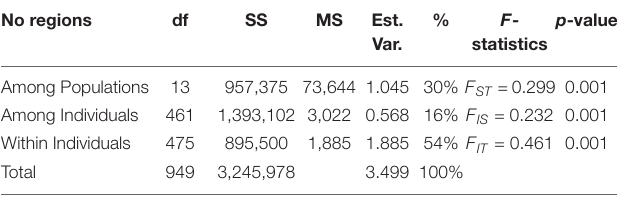
TABLE 3 | Summary of AMOVA and F -statistics of Avicennia marina for 14 populations in the Western Indian Ocean region. No regions Est.